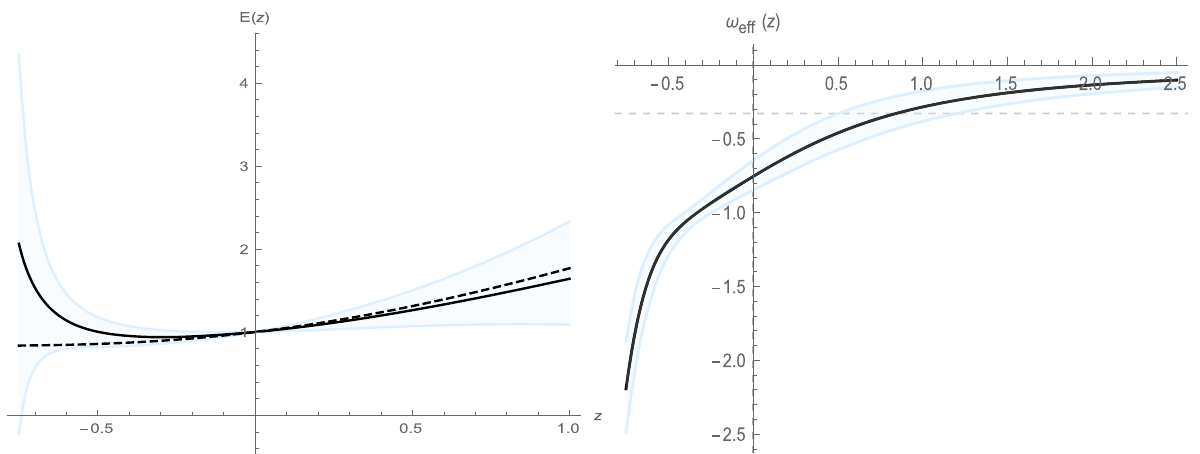
Fig. 3 On the left panel we can see the comparison between the nor- malized Hubble parameter of the model and the corresponding one to (cid:17) CDM model (dashed line) and the effective parameter state (right